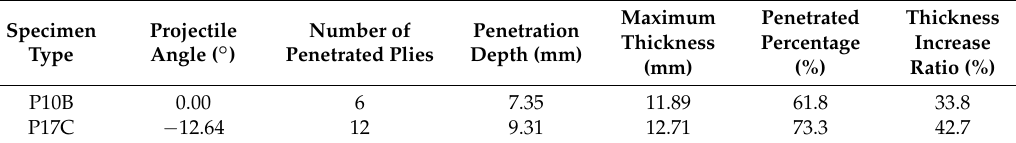
Figure 6. 2D slice images around the impact location of panel P17C. Table 6. Analyses on the impacted 2D slice images.